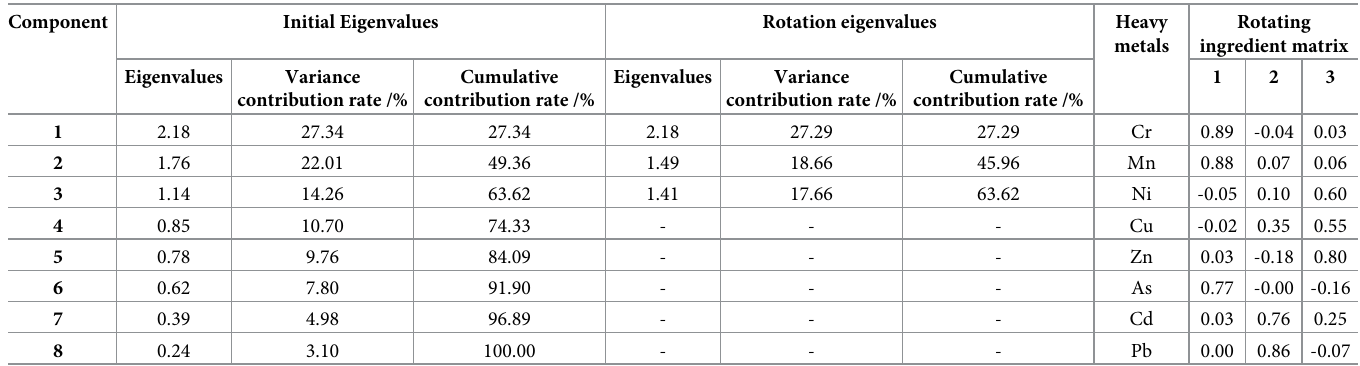
Table 5. PCA results of 8 heavy metals in